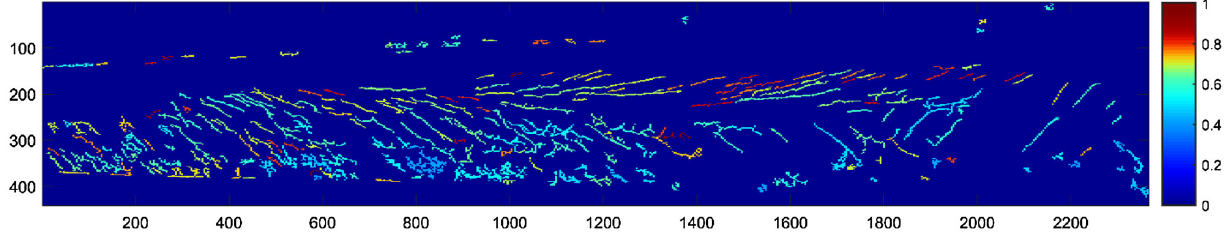
Fig. 6 Image objects with their PAR features (43 Mt) Fig. 7 Box plots of features for image objects